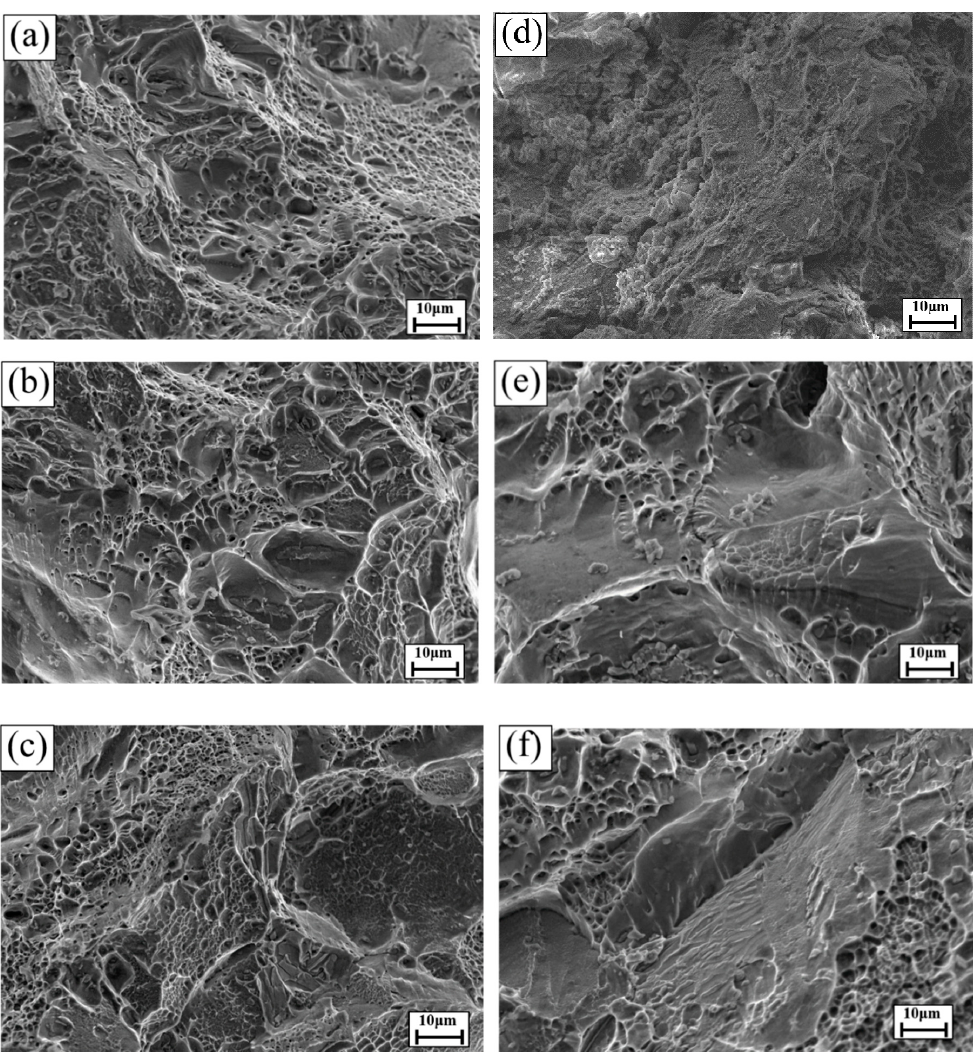
Figure 3. Fracture surface of A201-T7 alloys after slow strain rate testing: ( a ) NA0d sample in air; ( b ) NA1d sample in air; ( c ) NA4d sample in air; ( d ) NA0d sample in salt water; ( e ) NA1d sample in salt water; ( f ) NA4d sample in salt water. Materials 2020 , 13 , x FOR PEER REVIEW